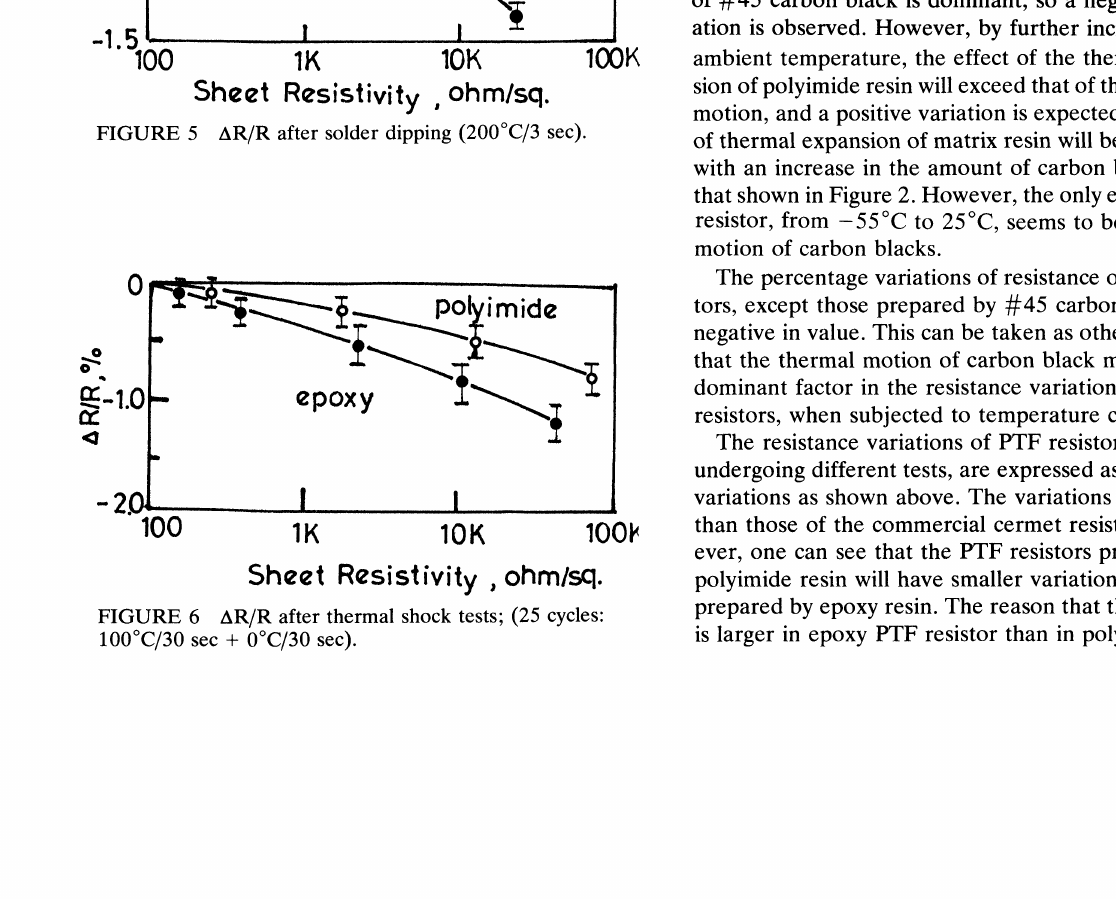
FIGURE 4 Long term drift characteristics of PTF resistors at 120C.